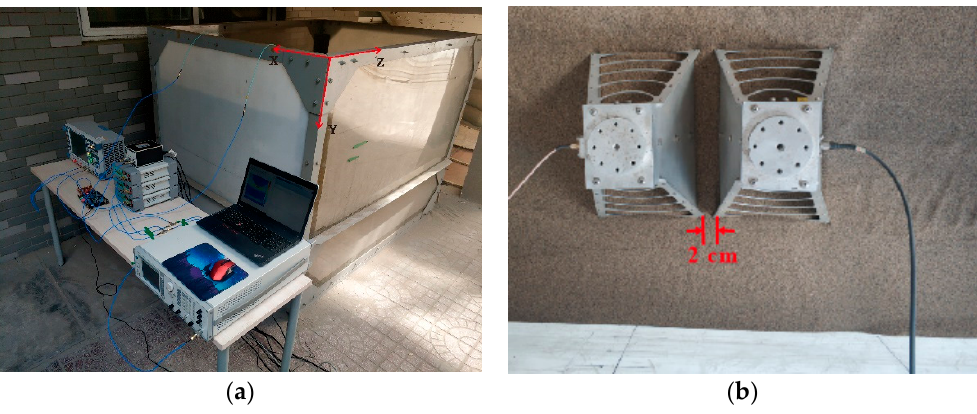
Figure 4. ( a ) The experimental scene of underground pipe location. ( b ) A photograph of the experimental tests in the sand container.